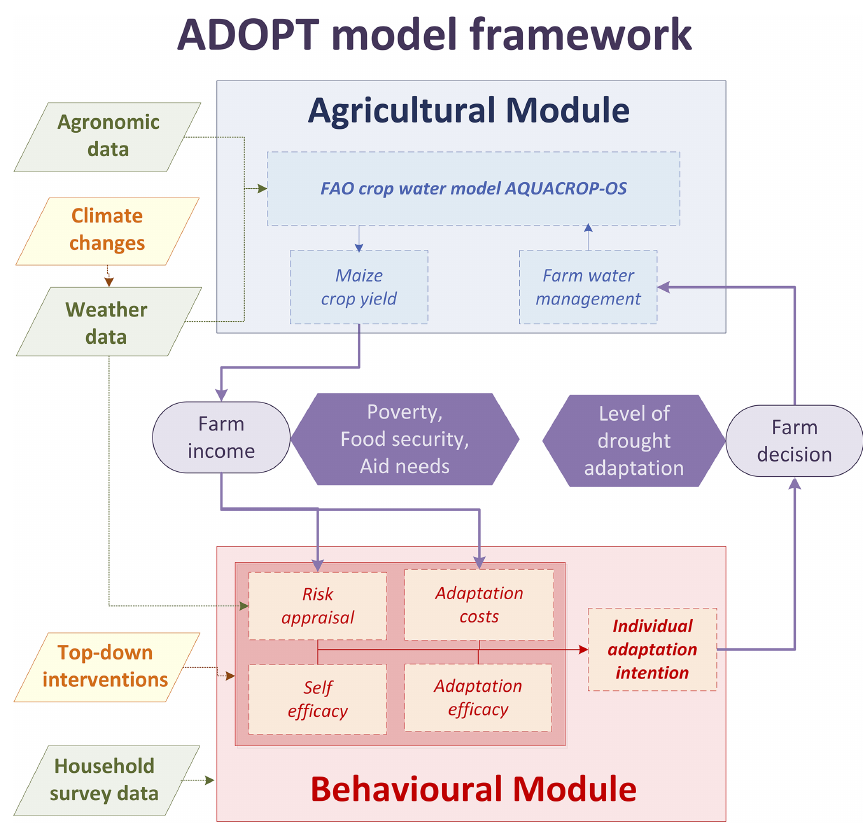
Figure 2. ADOPT model overview, adjusted from Wens et al. (2020). Description of the model (overview, design concepts, and details) in Appendix